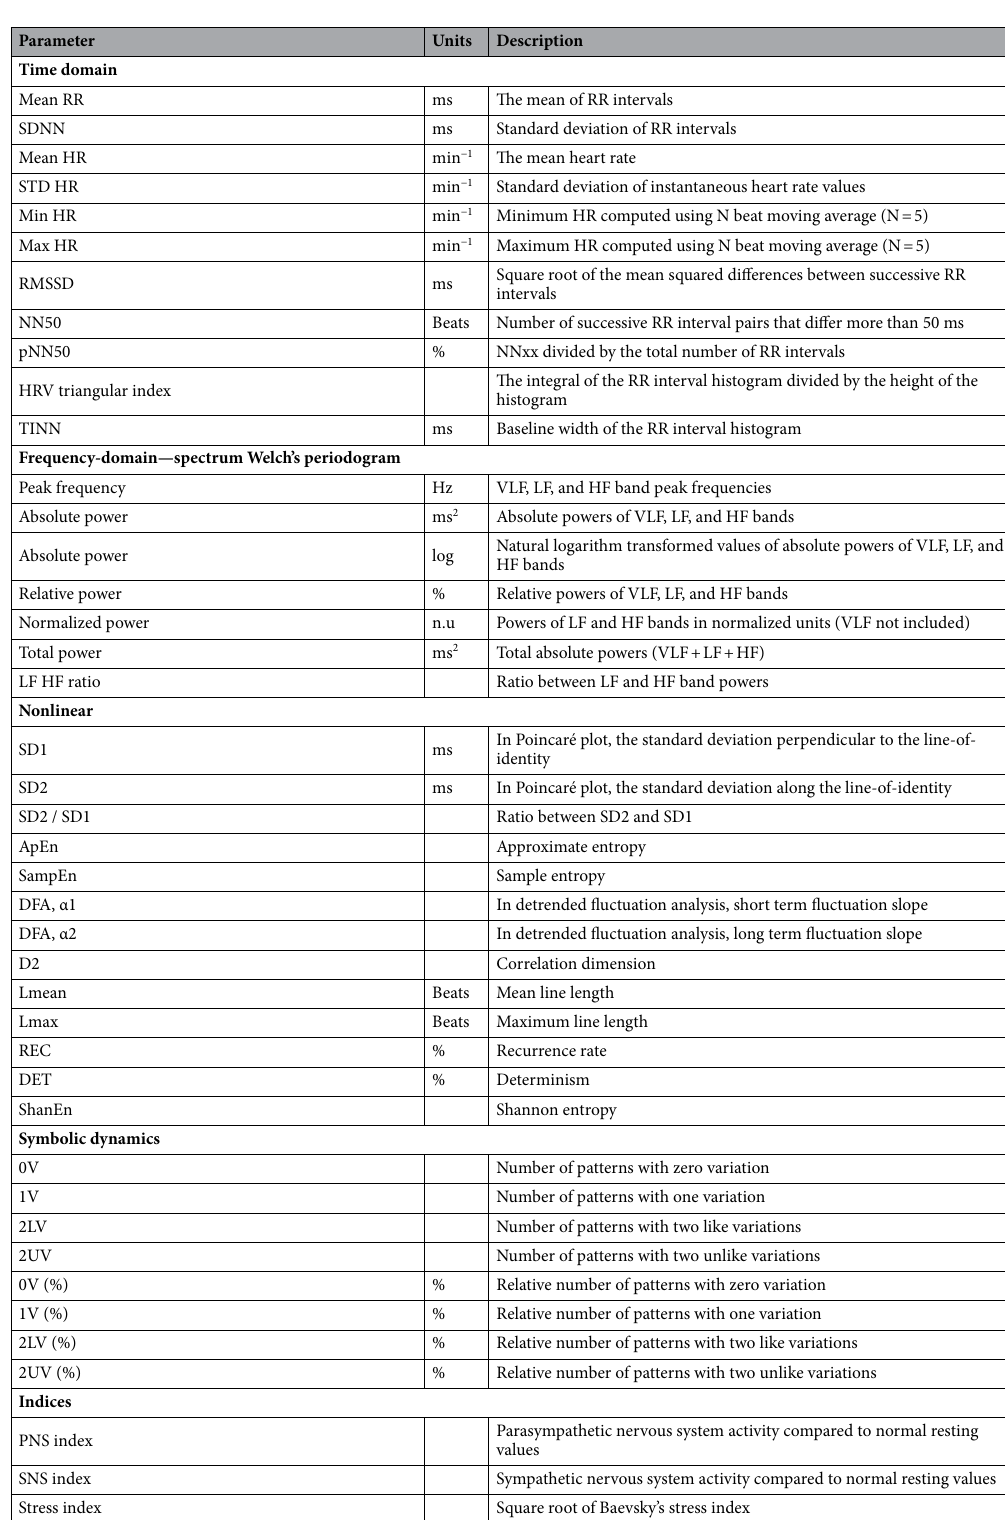
Table 2. Summary of executing HRV parameters according to 18,19